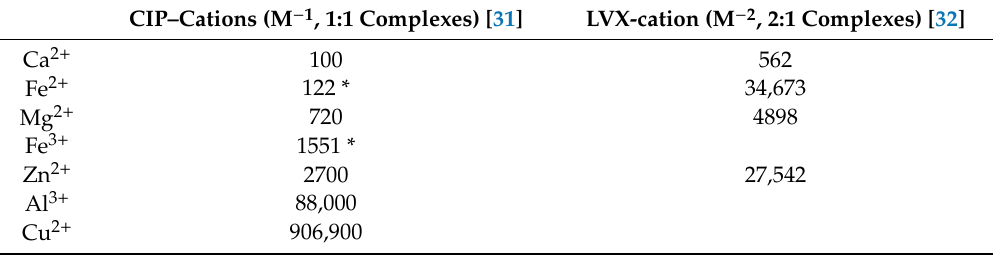
Table 1. Apparent association constant (Ka) between FQ and cations.